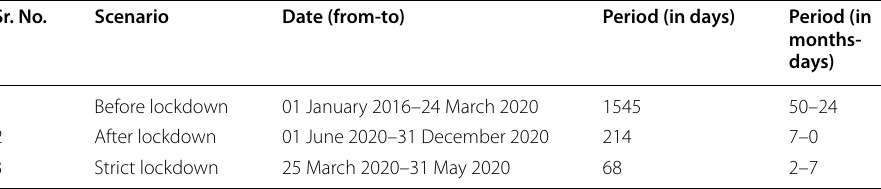
Table 1 The scenario of crash data Sr. No.